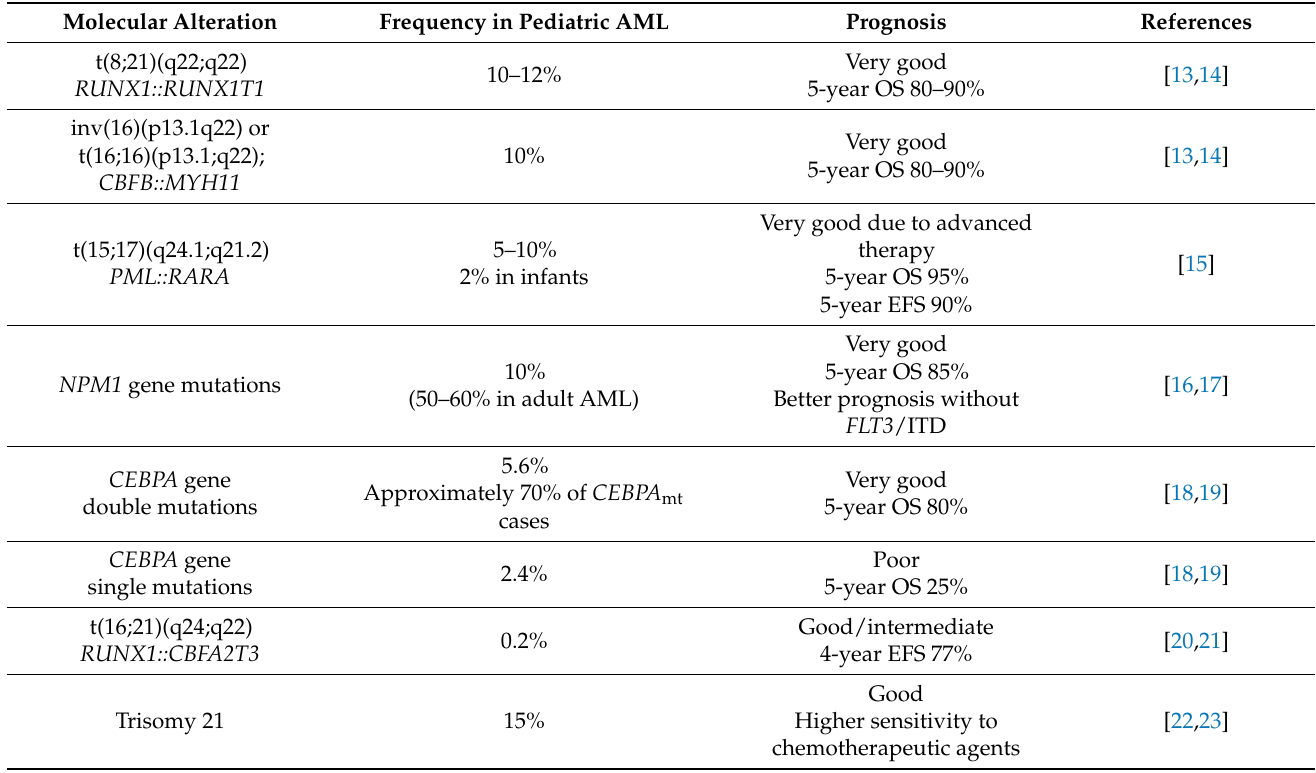
Table 1. Characteristics and prognosis in pediatric